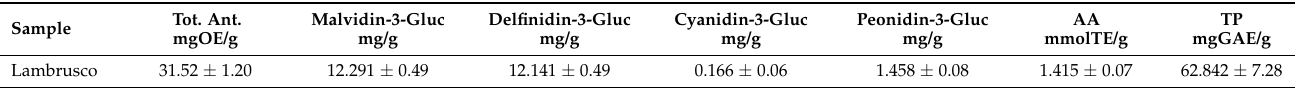
Table 2. Characterization of total anthocyanin content (Tot. Ant.) expressed as oenin equivalents (OE), main non-acylated anthocyanins, antioxidant activity (AA) and total phenol content (TP) in lyophilized water extract of Lambrusco pomace.